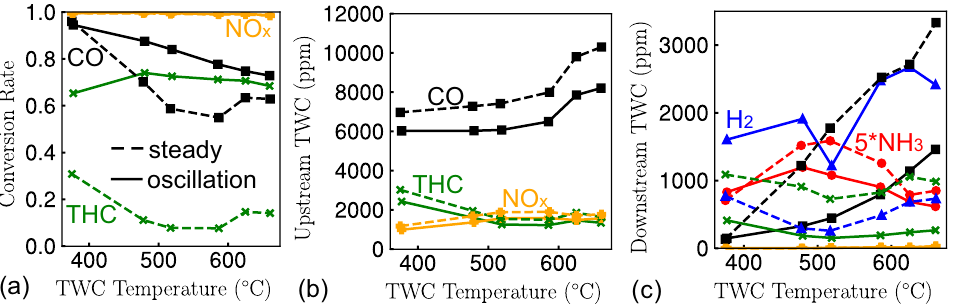
Figure 17. ( a ) Conversion rates of NO x , CO and THC upstream the TWC; ( b ) concentration of CO, THC and NO x upstream the TWC; ( c ) concentration of CO, THC and NO x downstream the TWC during steady and dithering